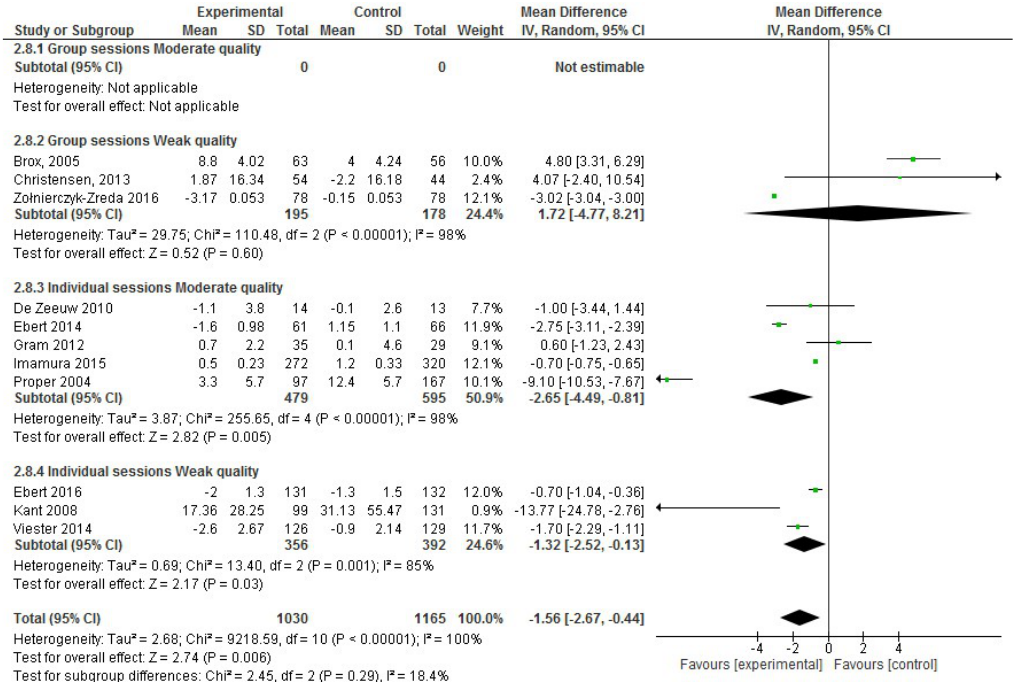
Figure 5. Forest plot of the e ff ectiveness of workplace interventions for reducing absenteeism when considering whether the intervention included group or individual sessions and according to the quality of the